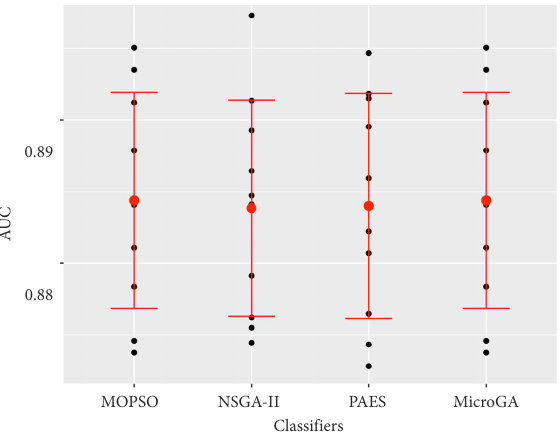
Figure 15. AUC boxplot Table 9. Experimental results from the lending club